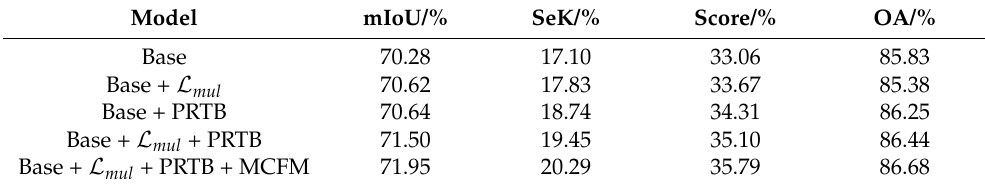
Figure 8. Comparisons of the results provided by the BIT and Ours. We highlight interesting regions with orange boxes. Definitions : S-map, semantic map. Table 3. Ablation study on the SECOND dataset.